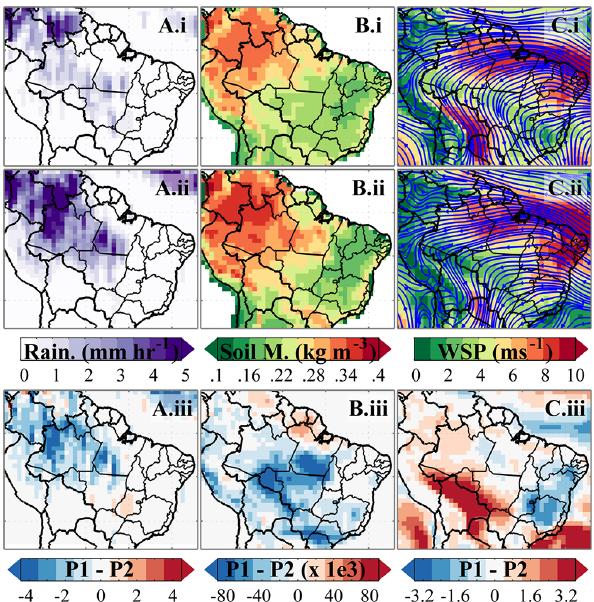
Figure 4. Precipitation (a) , soil moisture (b) and 850hPa wind speed and flowlines (c) during meteorological phases 1 ( i , dry sea- son) and 2 ( ii , dry–wet transition season) and the difference between the two periods ( iii ). Precipitation is derived from TRMM measure- ments. The soil moisture and wind speed products are derived from the ECMWF ERA-Interim